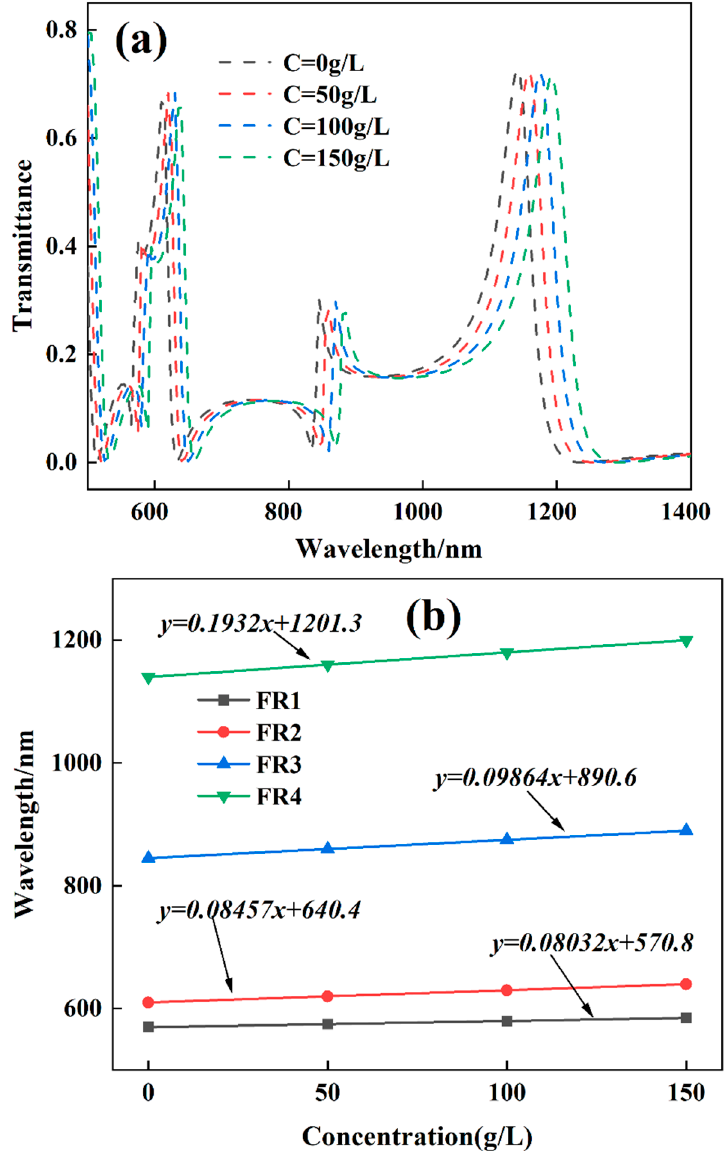
Figure 10. ( a ) Transmission spectra of Fano resonances at different glucose solution concentrations. ( b ) Relationship between quadruple Fano resonances wavelength and glucose solution concentra- tion.